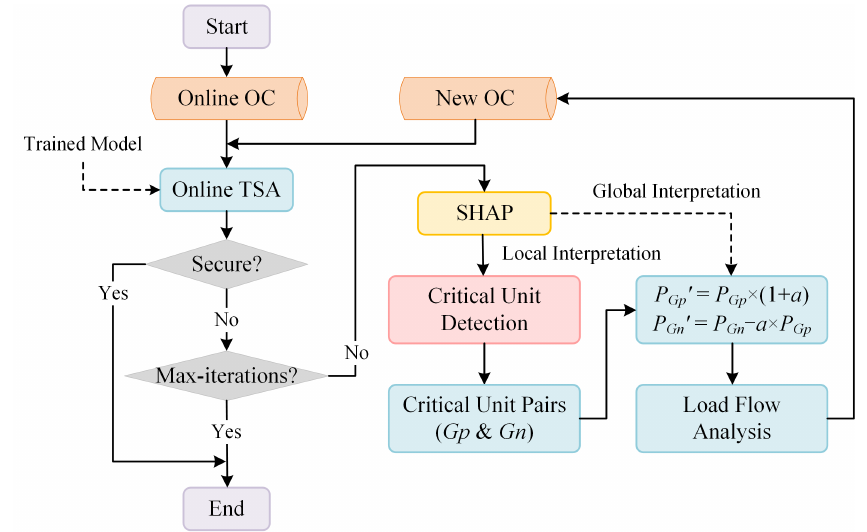
Figure 2. The flow chart of online security control based on